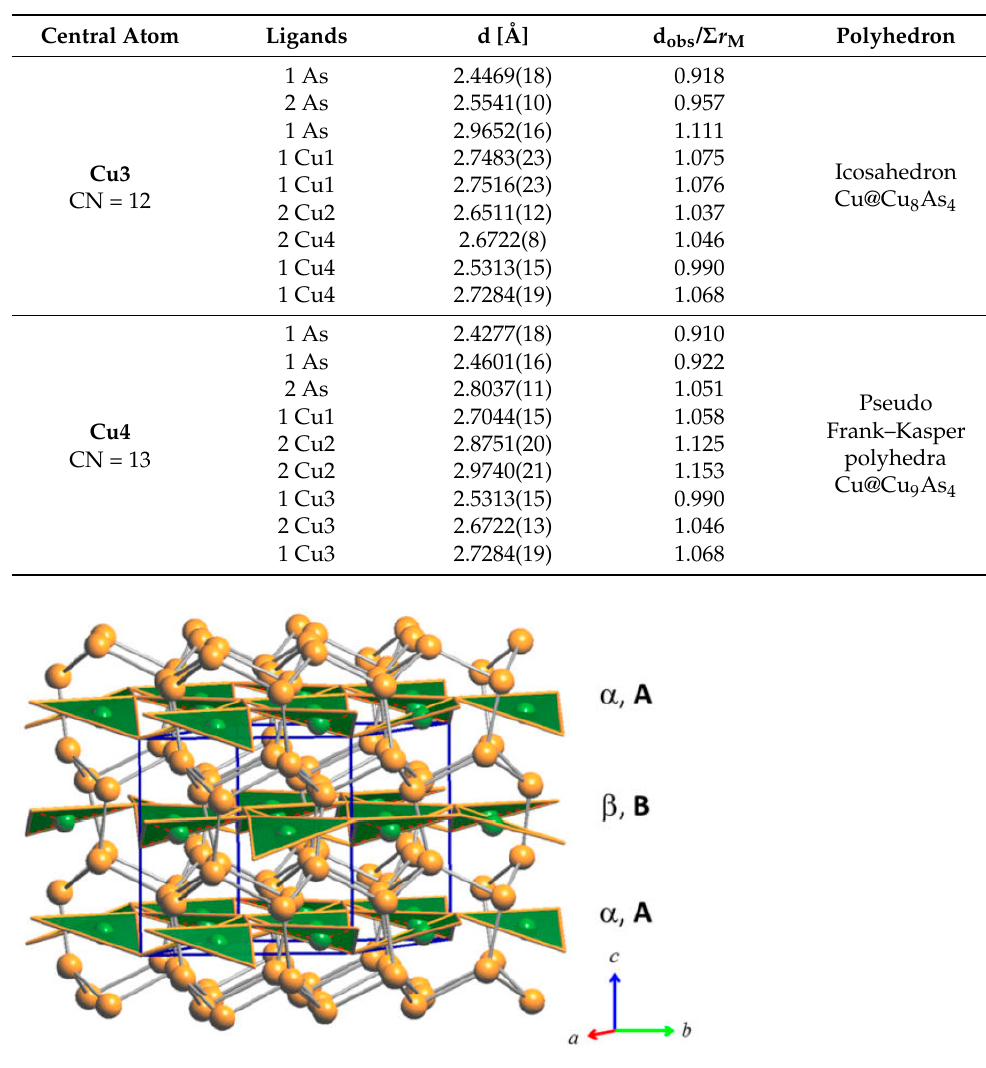
Figure 6. Perspective drawing of the RT structure of the Cu 3 As compound. Each unit cell contains two layers, α and β , of vertex-sharing triangular ‘Cu 3 As’ units. Orange and green balls indicate Cu and As atoms, respectively.